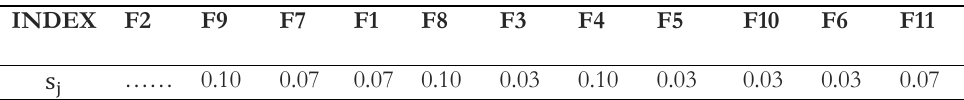
Table 9. Amount of sj.